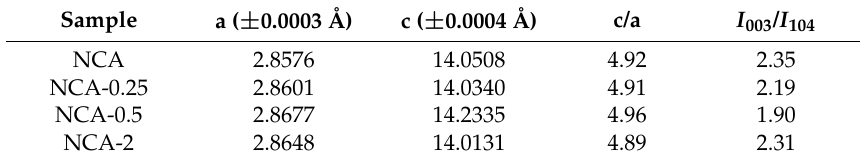
Table 1. Lattice parameters and the values of I 003 / I 104 for NCA, NCA-0.25, NCA-0.5 and NCA-2. Sample